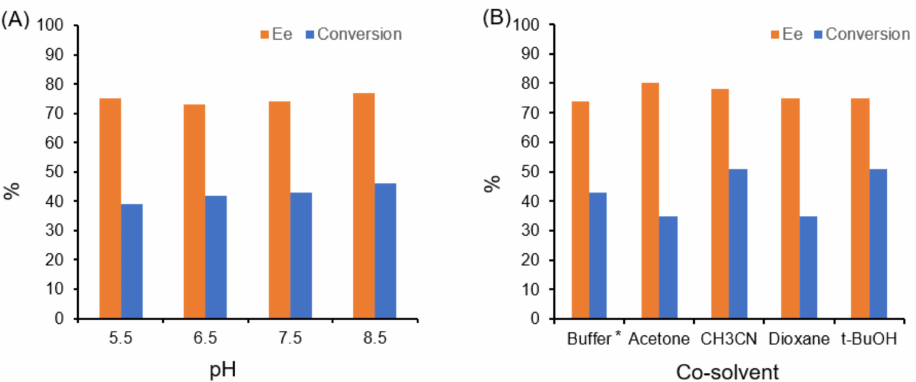
Figure 1. Influence of pH variation ( A ) and addition of cosolvents (20% v / v ) in the reaction medium ( B ) for the biocatalyzed sulfoxidation of thioanisole (1 h reaction time, 0.6 eqv. of oxidant added, Buffer * = pH